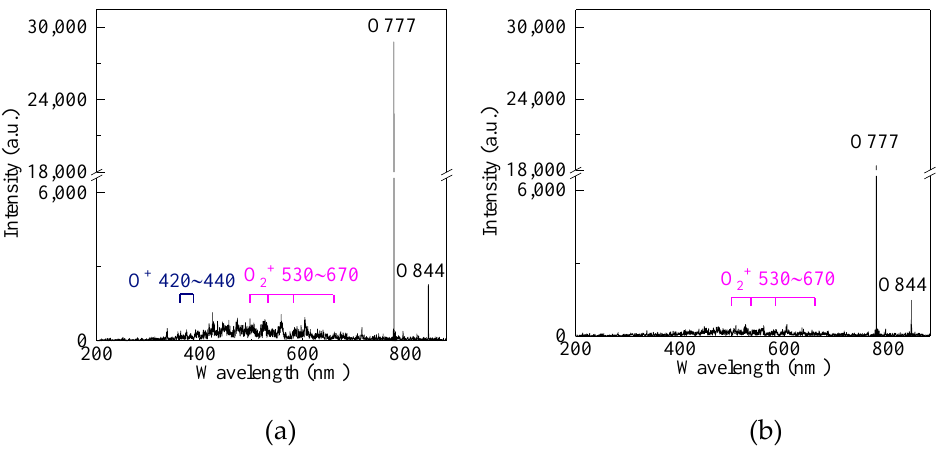
Figure 7. Emission spectrum of ( a ) SDBOR and ( b ) DDBOR (applied voltage = 2.8 kV mm, discharge gap = 0.5 mm).